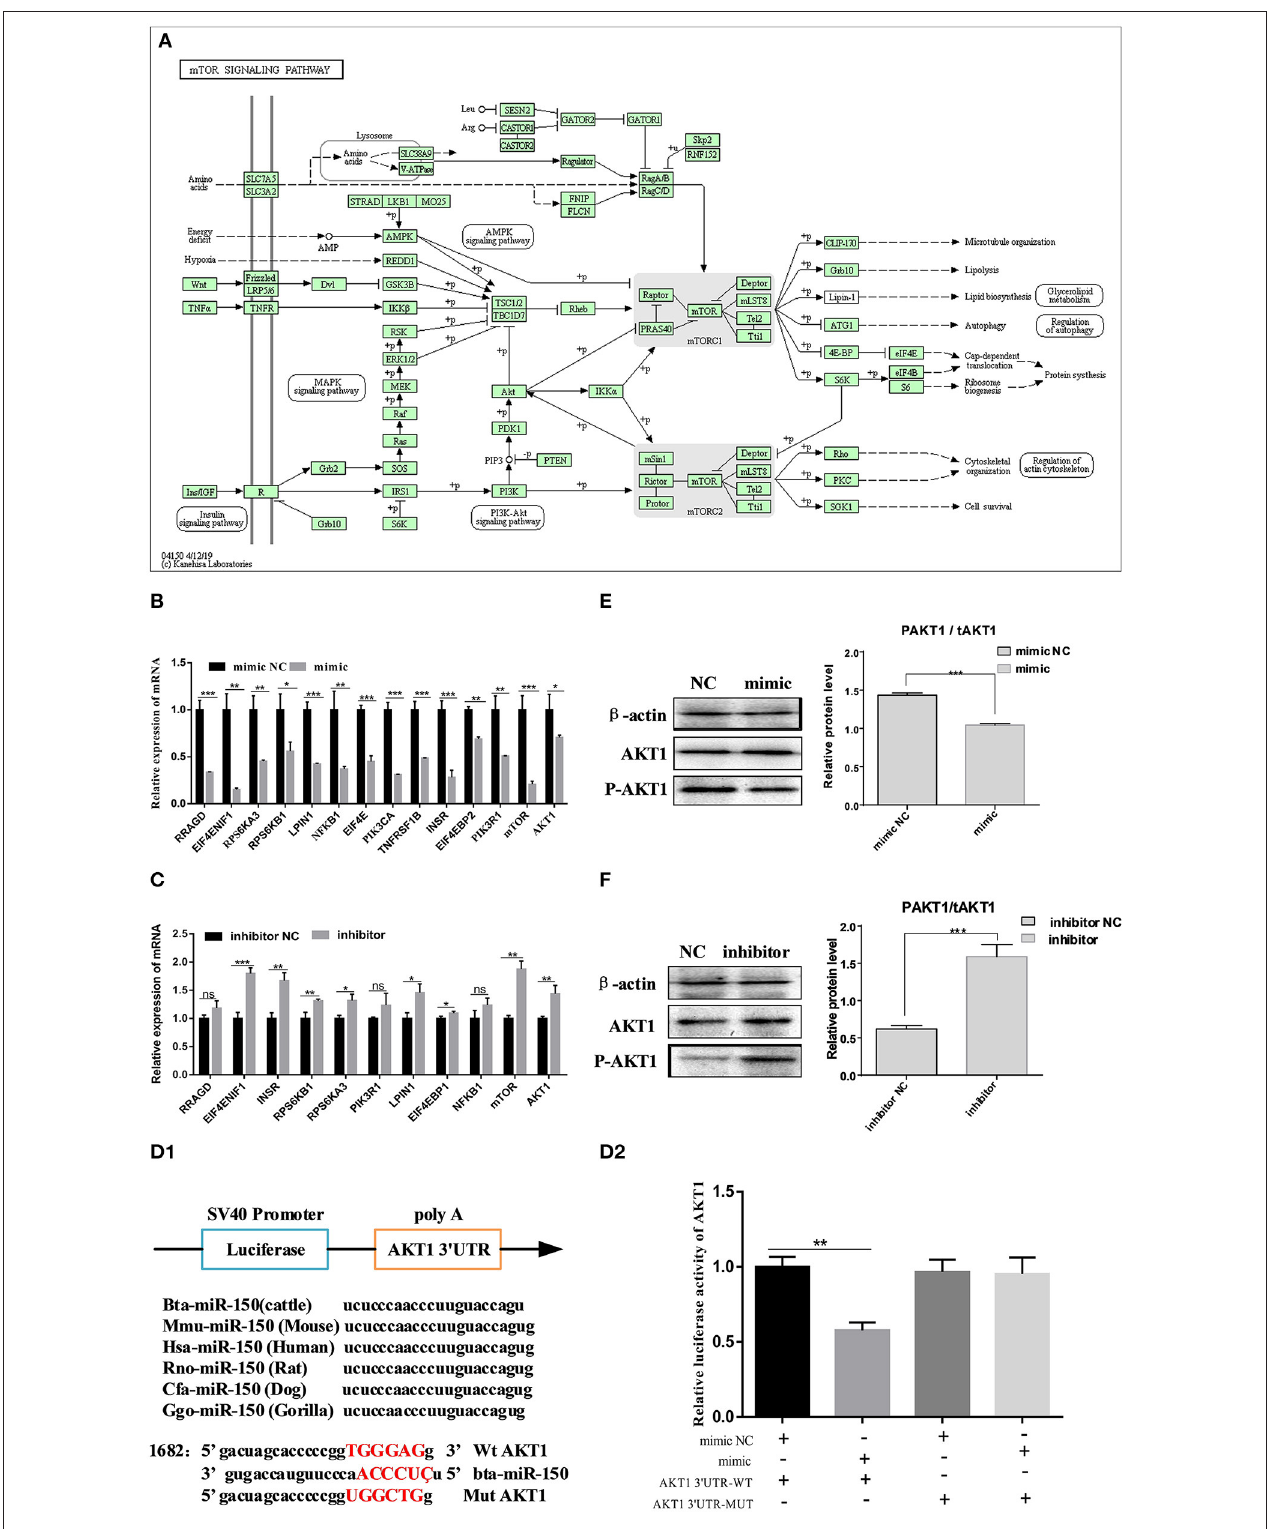
FIGURE 5 | bta-miR-150 directly targets AKT1 and regulates adipocyte differentiation through mTOR pathway. (A) mTOR signaling pathway. (B,C) Changes in mRNA levels in the mTOR pathway on day 2 after incubation with the mimic, inhibitor, and NC. (D1) Construction of a double luciferase reporter vector; (D2) Changes in luciferase activity after co-transfection. (E,F) Western blots of Akt1 phosphorylation on day 2 of differentiation. Error bars, means ± SD. n = 3 replicates. *denotes significance according to Student’s t -test, * p < 0.05, ** p < 0.01, *** p < 0.001, and **** p < 0.0001.